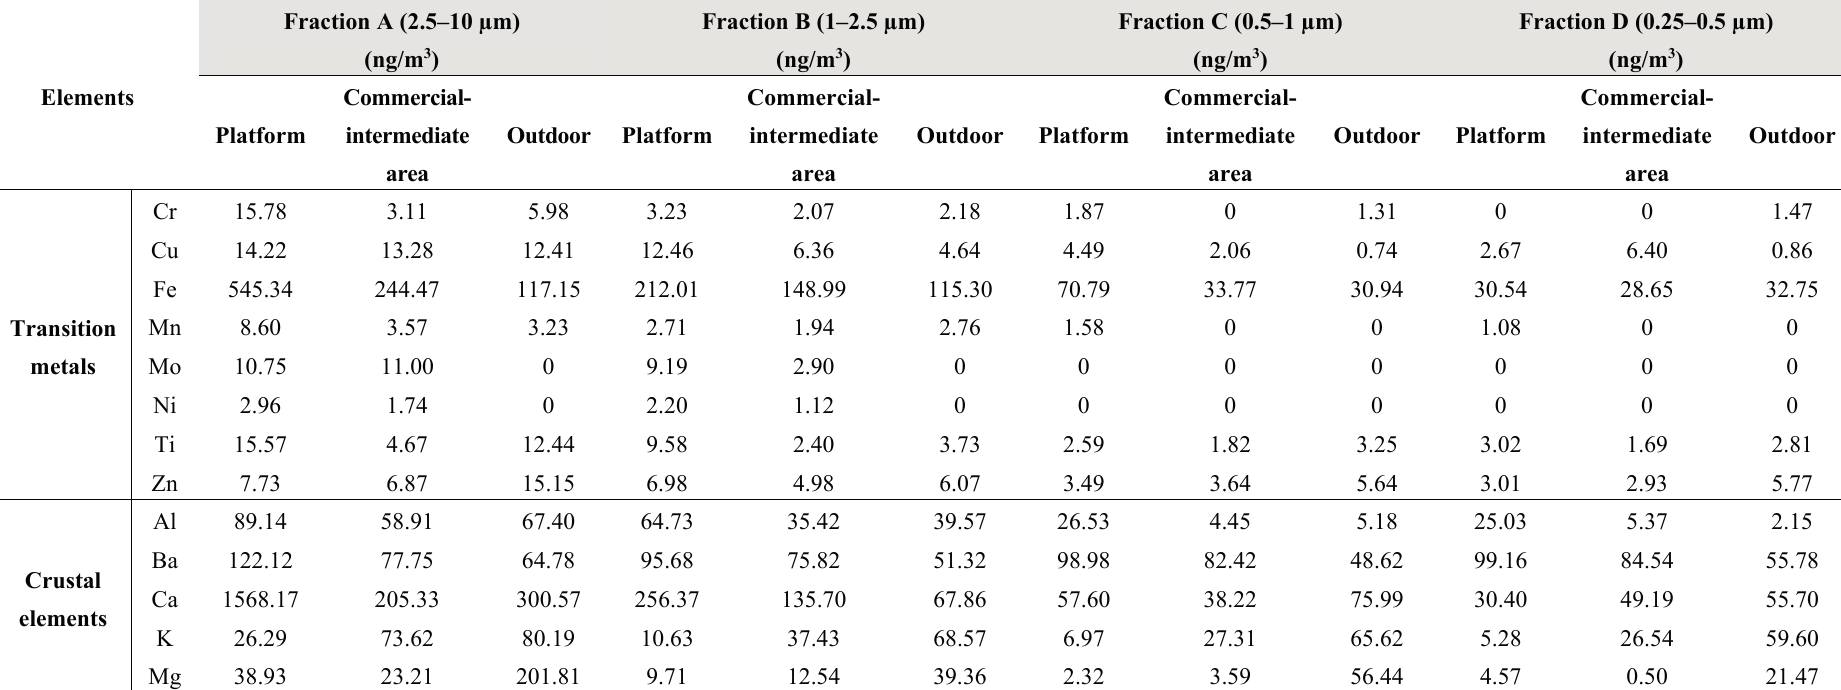
Table 1. Concentrations (ng/m 3 ) of transition metals and crustal elements in the various fractions of particulate matter (A, B, C, D) collected at the three sites